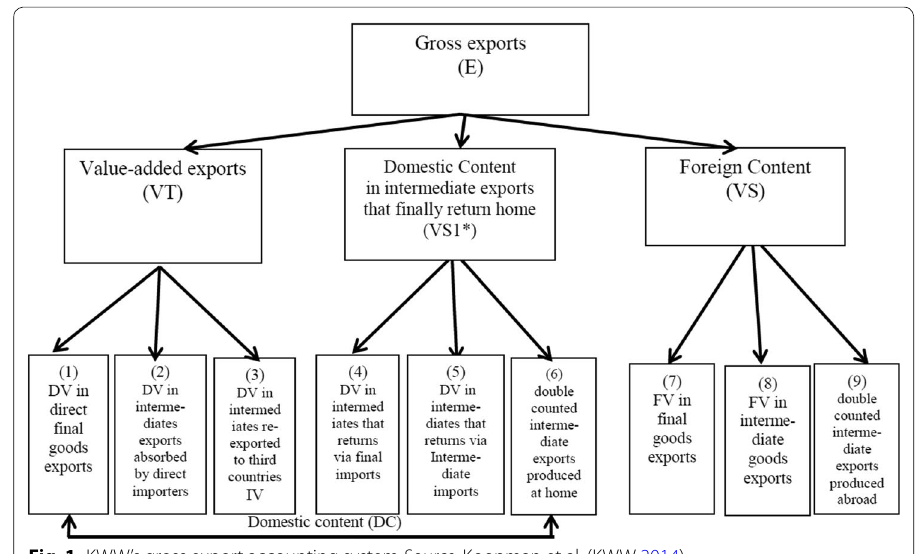
Fig. 1 KWW’s gross export accounting system Source: Koopman et al. (KWW